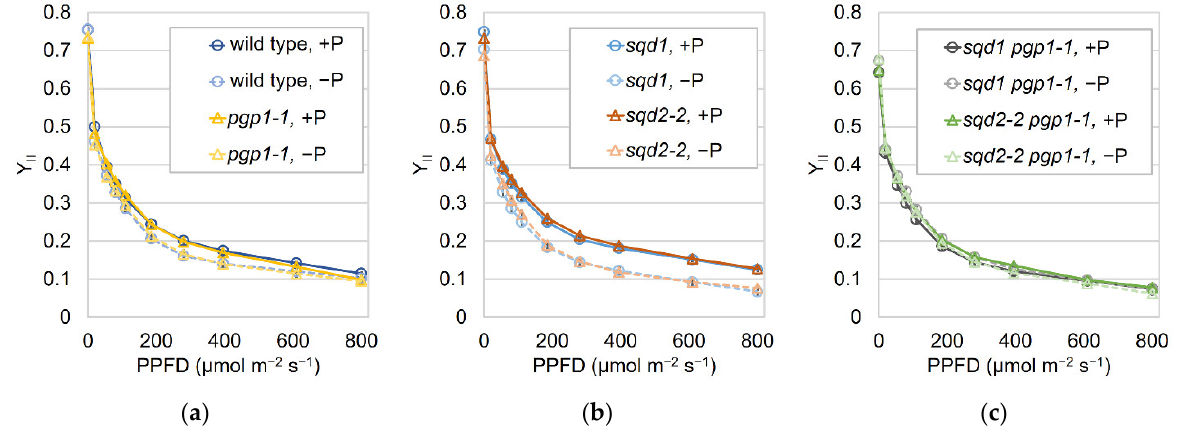
Figure 3. Light–response curves of effective photosystem II quantum yield (Y II ) in wild type and anionic lipid mutants grown under P-sufficient (+P) and -starved (−P) conditions. ( a , b ) Wild type, pgp1-1 , sqd1 , and sqd2-2 were grown for 7 d and ( c ) sqd1 pgp1-1 and sqd2-2 pgp1-1 were grown for 11 d under the +P condition, followed by the growth under the +P or −P condition for 7 d. Data are means ± SE of 13, 15, 21, 19, 20, and 22 seedlings for the +P condition and 6, 8, 20, 17, 22, and 26 seedlings for the −P condition of wild type, pgp1-1 , sqd1 , sqd2-2 , sqd1 pgp1-1 , and sqd2-2 pgp1-1 , respectively. PPFD, photosynthetic photon flux density.